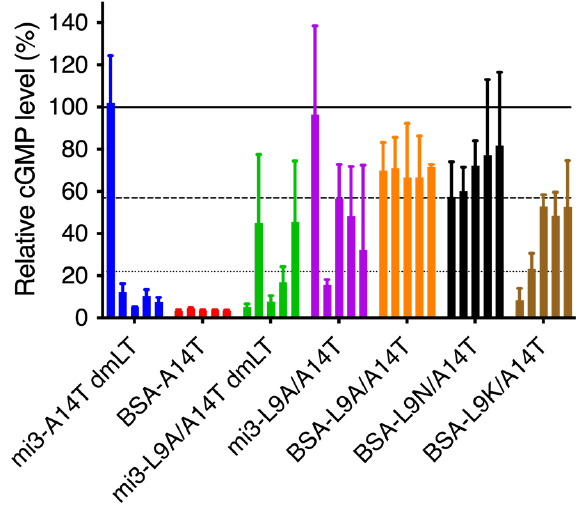
Figure 4. Neutralization of native STh by sera from mice immunized with ST toxoids. Neutralization was assessed using the T84 cell assay, and the estimated cGMP production is given in percent relative to the negative control results where no serum was added (vertical axis). The bars represent the mean results from two separate experiments conducted with technical duplicates, and the error bars indicate the standard deviations. The solid line indicates a relative cGMP level of 100%. The dashed line indicates a relative cGMP level of 57.5%, which was the lowest level observed with a serum containing anti-STh titers <250 (BSA-L9N/A14T serum 1). Sera with such low levels of antibodies are unlikely to be neutralizing. The dotted line indicates a relative cGMP level of 22.5%, below which the cGMP levels are significantly ( p < 0.05) different from that of the non-neutralizing BSA-L9N/A14T serum 1, according to a two-way ANOVA followed by Fisher’s LSD test. We consider this to be the threshold below which one can safely conclude that true neutralization is observed.